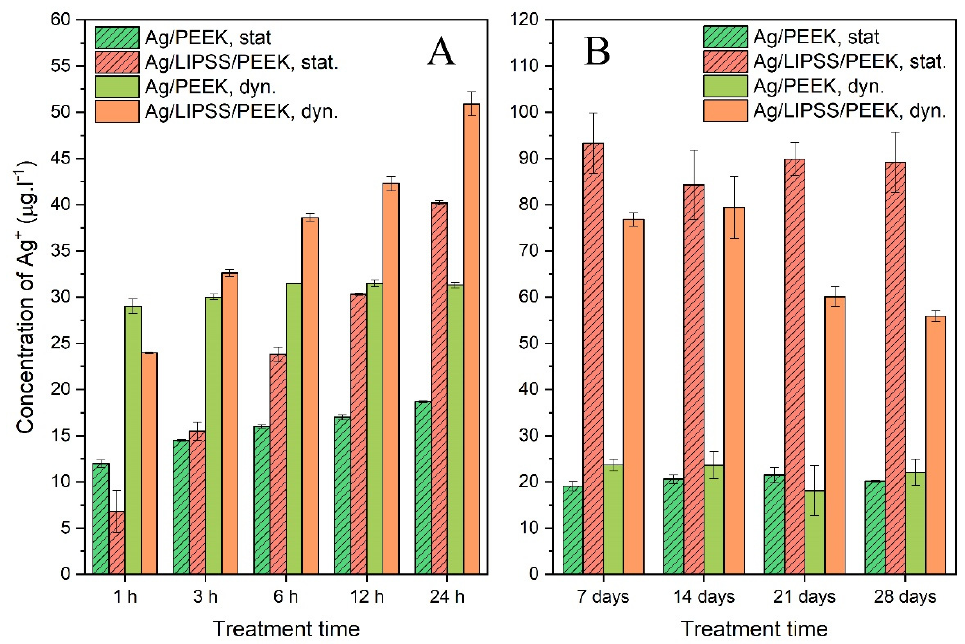
Figure 5. Concentration of Ag ions in leachates after treatment of Ag-immobilized samples in water determined by the ICP-MS technique for short-term ( A ) and long-term ( B ) experiments.